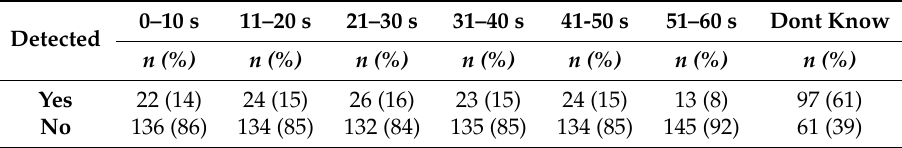
Table 2. Scenario one detection rate (no